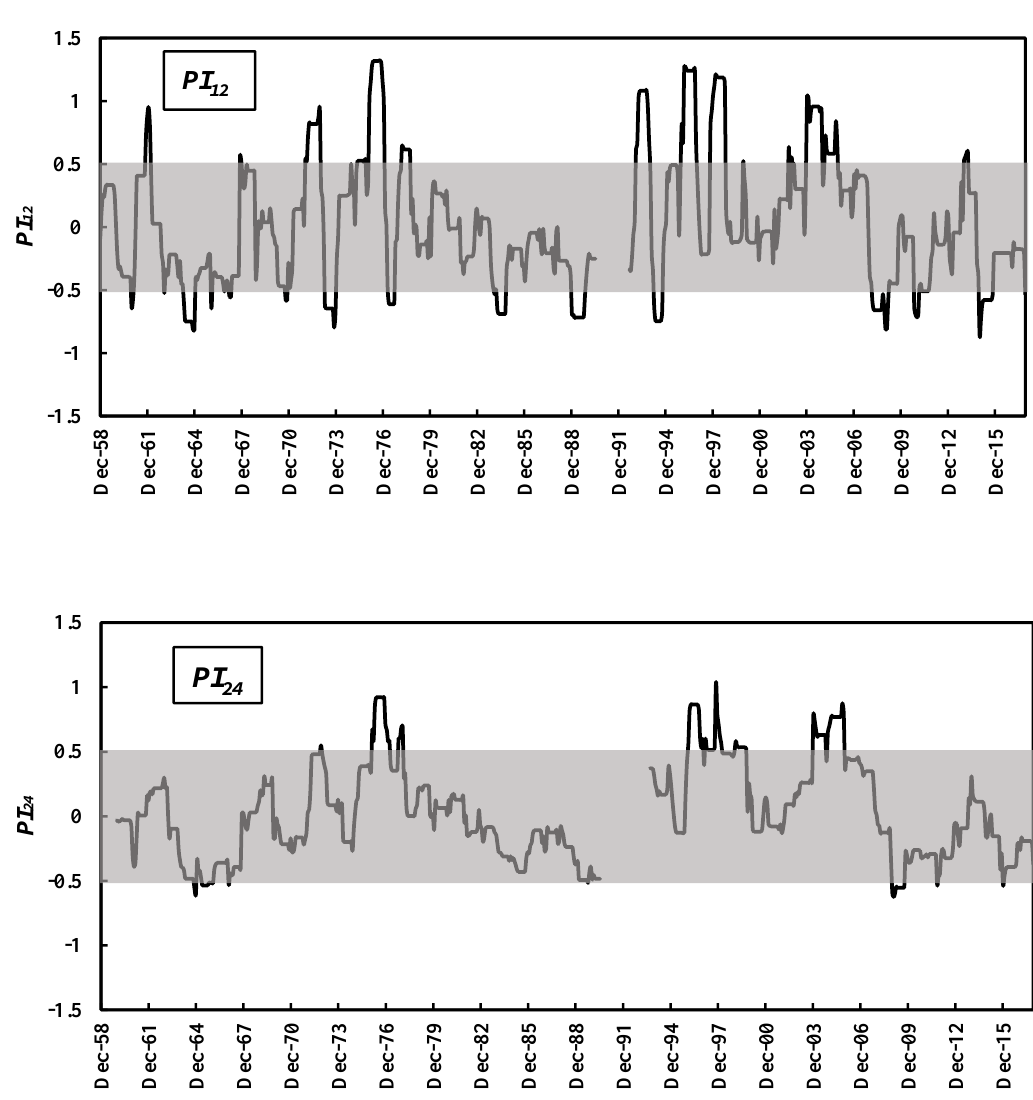
Figure 5. PI versus time at: 12-month timescale and 24-month timescale. Shaded area denotes no drought condition. PI was not calculated for the missing data period